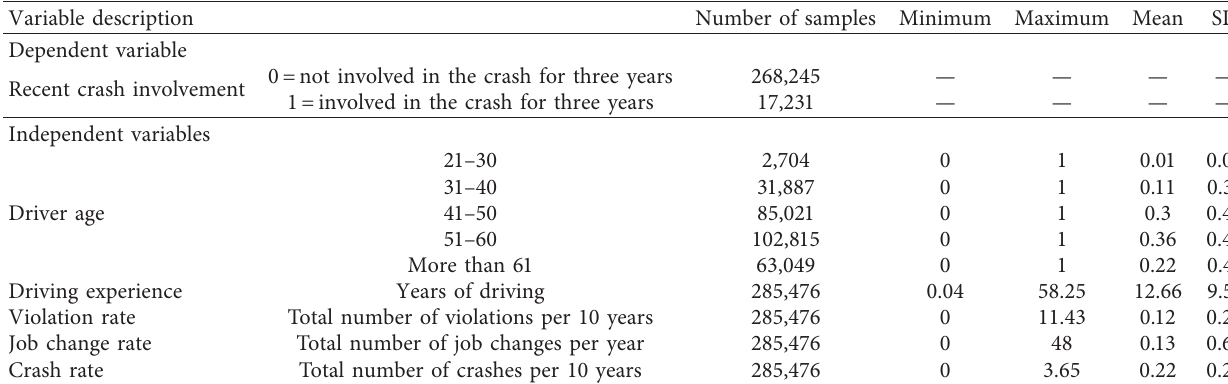
Table 4: Descriptive statistics of variables for